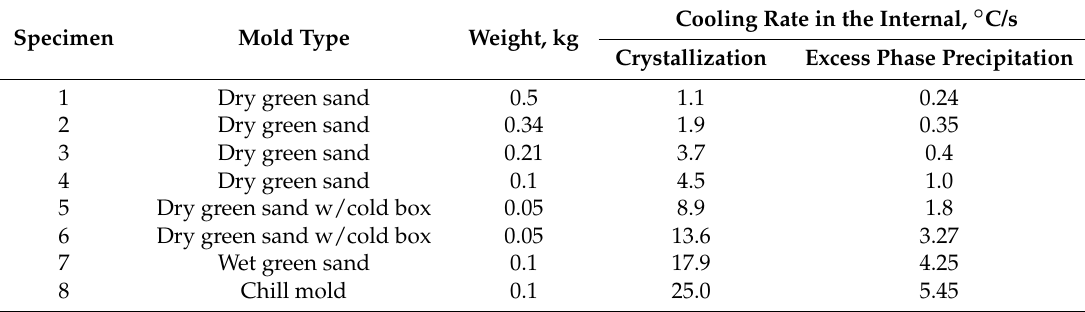
Table 2. The mold type and the specimen weight in relation to cooling rates.